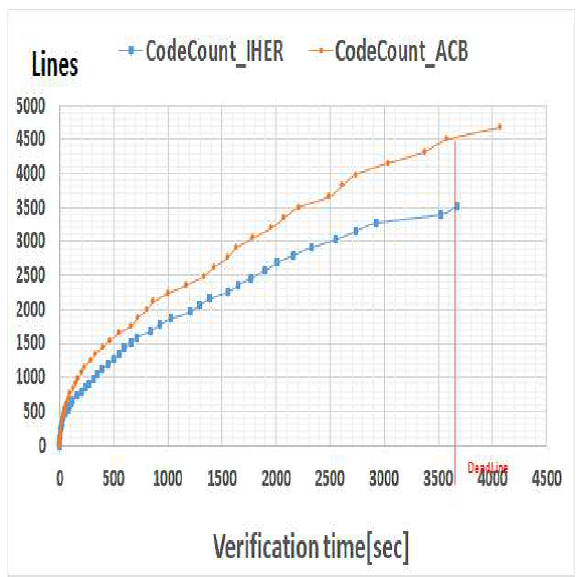
Figure 12. Verification lines of program 1 for verification time.